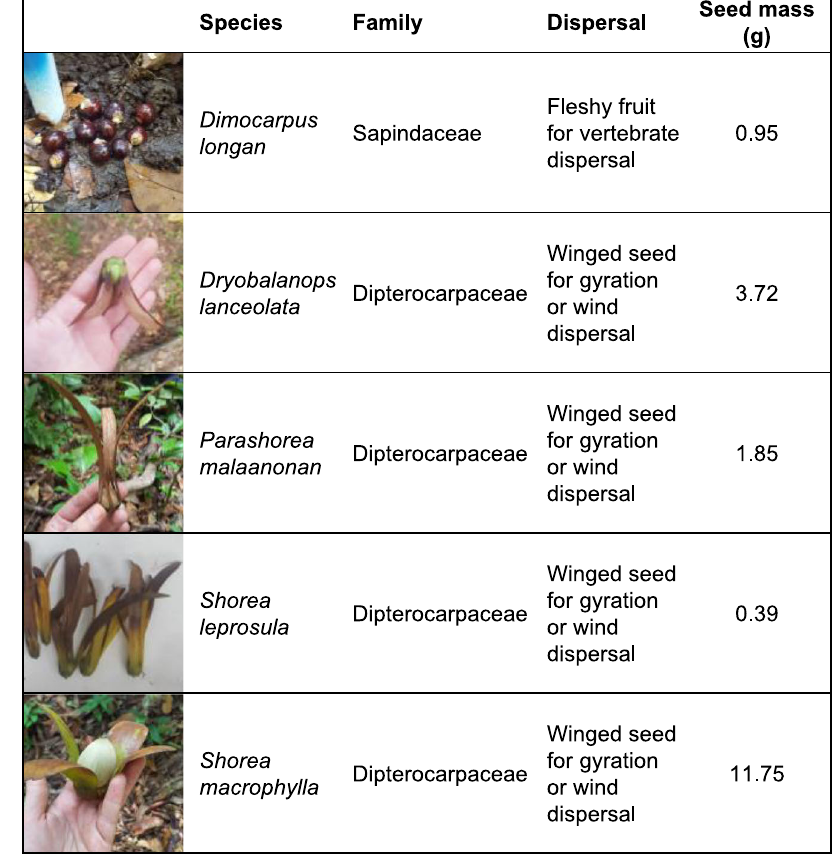
Fig. 2 Species used in experiment. Information on the fi ve tree species used in the nested exclusion experiment